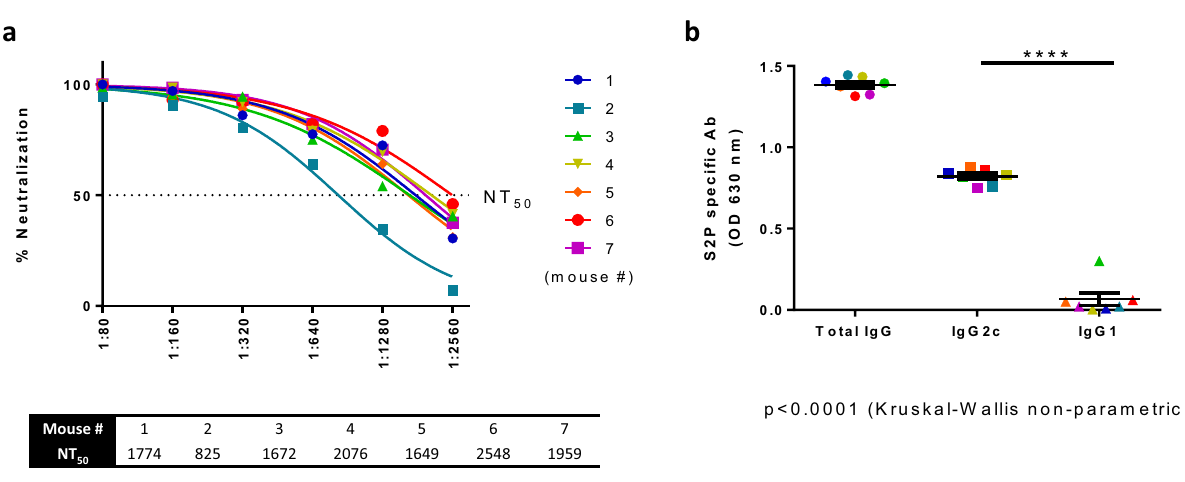
Fig. 8 Th1 and Th2 isotytpe analysis of rVSV- Δ G-spike induced antibodies. rVSV- Δ G-spike vaccinated (10 7 pfu/mouse, n = 7) C57BL/6J mice sera analysis for a NT 50 values against SARS-CoV-2 as determined by PRNT, and b levels of S2P speci fi c binding antibodies: total IgG, IgG2c, and IgG1 as determined by ELISA. Statistical signi fi cance was determined using one-way ANOVA nonparametric test, with Kruskal – Wallis test: **** p < 0.0001. Each mouse is represented by a different color. Source data are provided as a Source Data fi